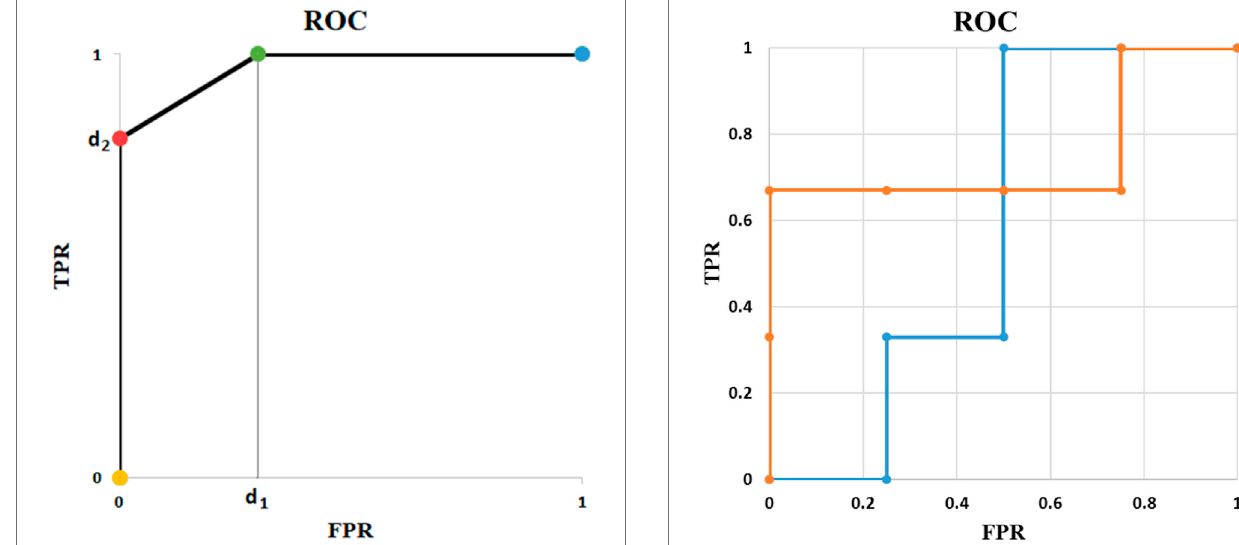
FIGURE 6 | ROC of Example of Table 10 . FIGURE 7 | ROC curves for two different models with N (cid:1)